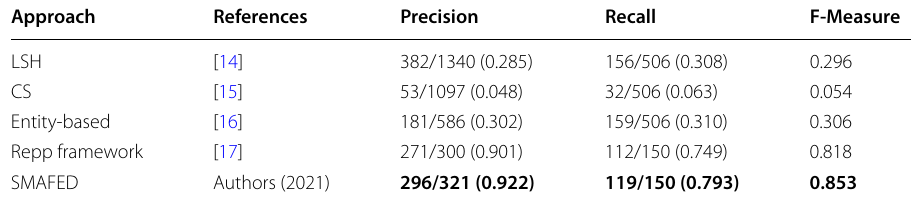
Table 18 The results of LSH, CS, Entity-based approach, Repp Framework and SMAFED on Event2012 Twitter Dataset